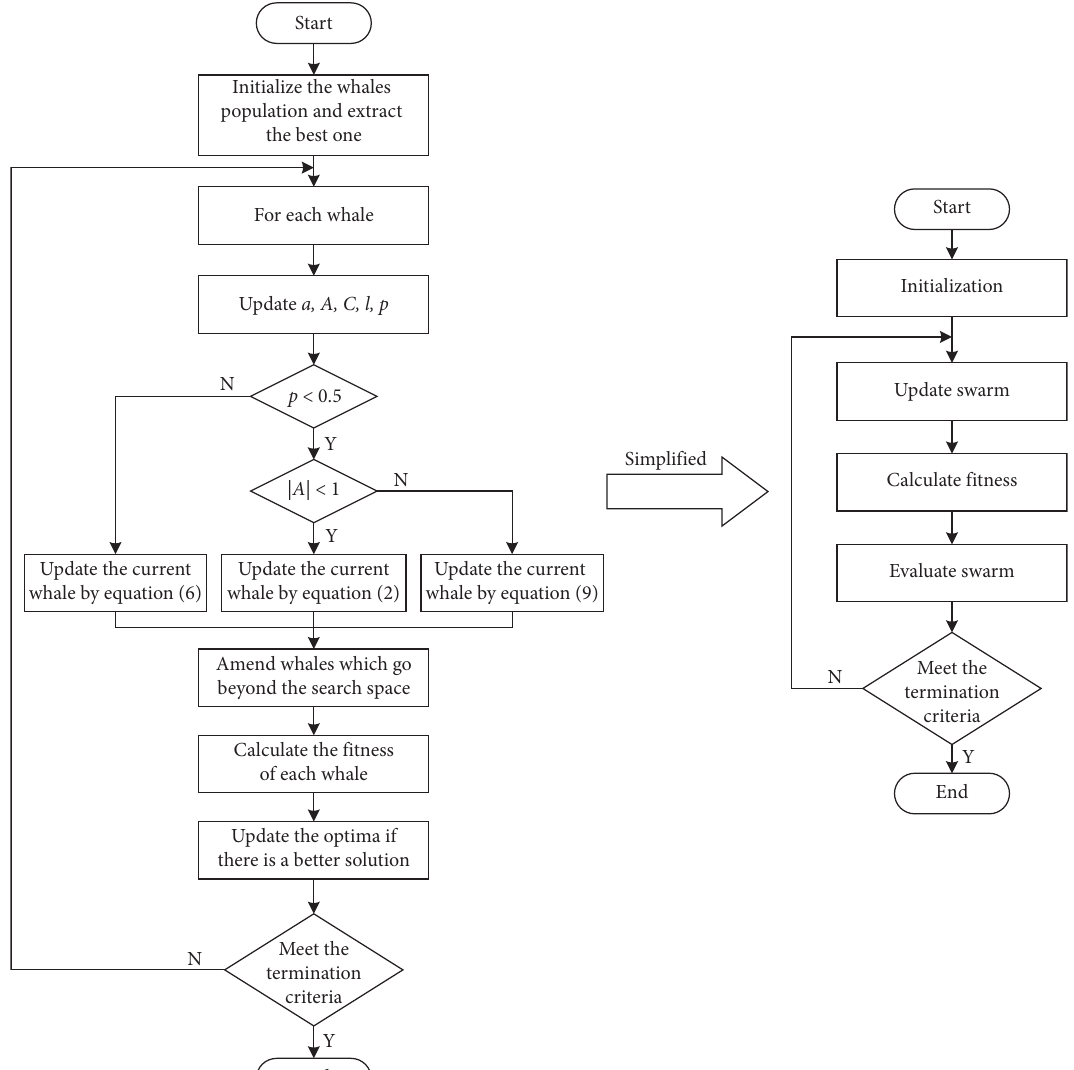
Figure 2: Framework of the WOA